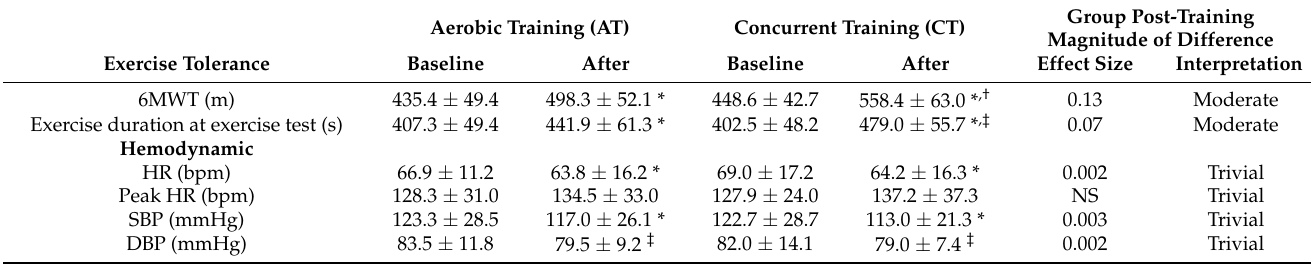
Table 2. Changes in hemodynamic and exercise tolerance parameters at baseline and after training. Aerobic Training